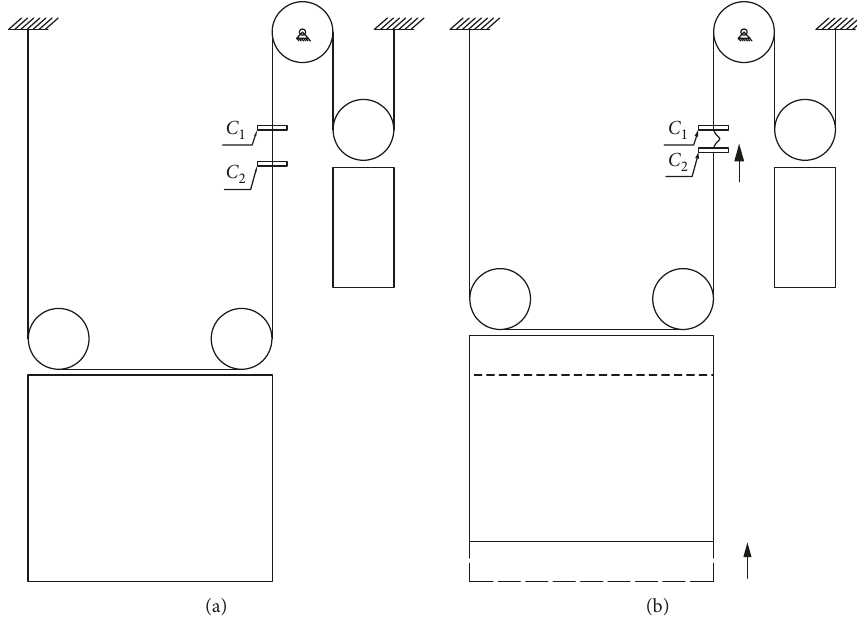
Figure 5: Schematic diagram of quality test. C1: clamp 1; C2: clamp 2. (a) Fixture installation. (b) Wire rope bending in